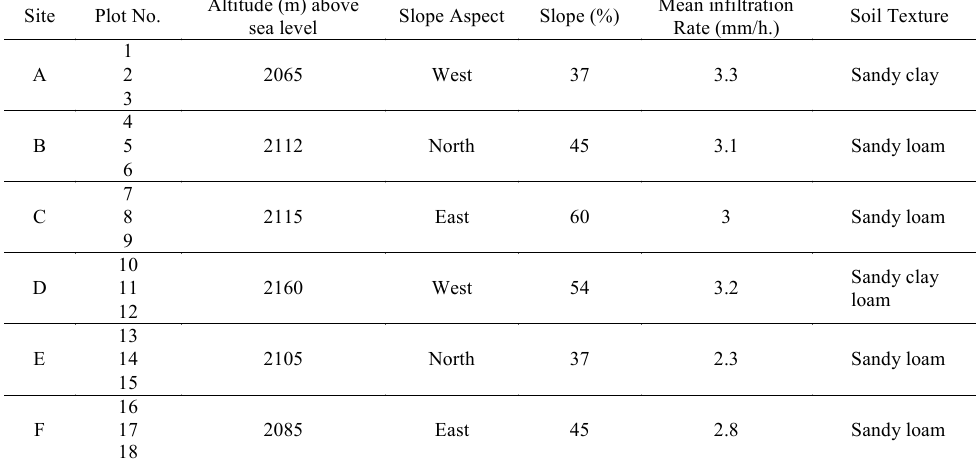
Table 2: Physical characteristics of the installed erosion plots Altitude (m) above Site Plot No. Slope Aspect Slope sea level